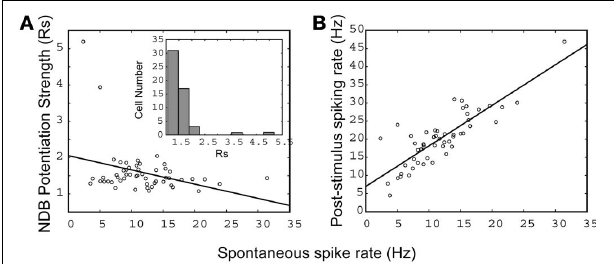
FIGURE 5 | The relationship between spontaneous activity and NDB potentiation strength (A), and post-stimulus activity (B). A linear fit is applied and the correlation coefficient is indicated separately: (A) r = − 0 . 38, (B) r = 0 . 89 ( n = 57). ( A , inset), a histogram shows the distribution of cells with NDB stimulation-induced response strength (Rs).